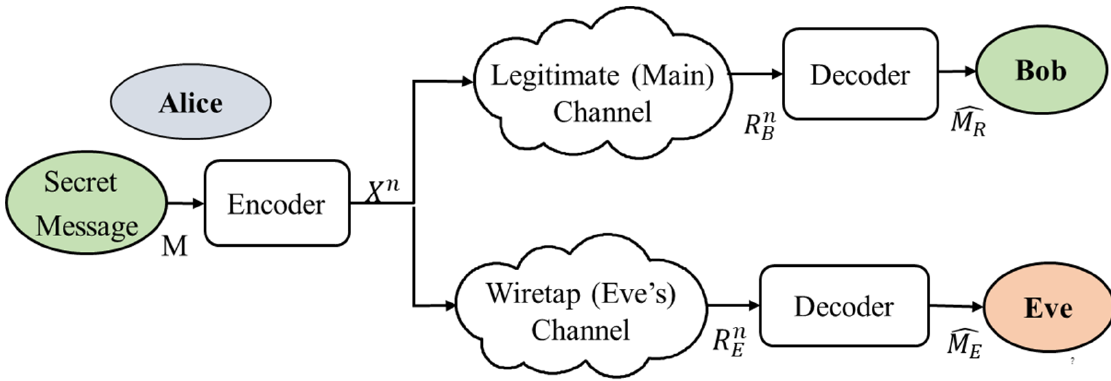
Figure 1. Generic system model of an Alice–Bob–Eve channel.